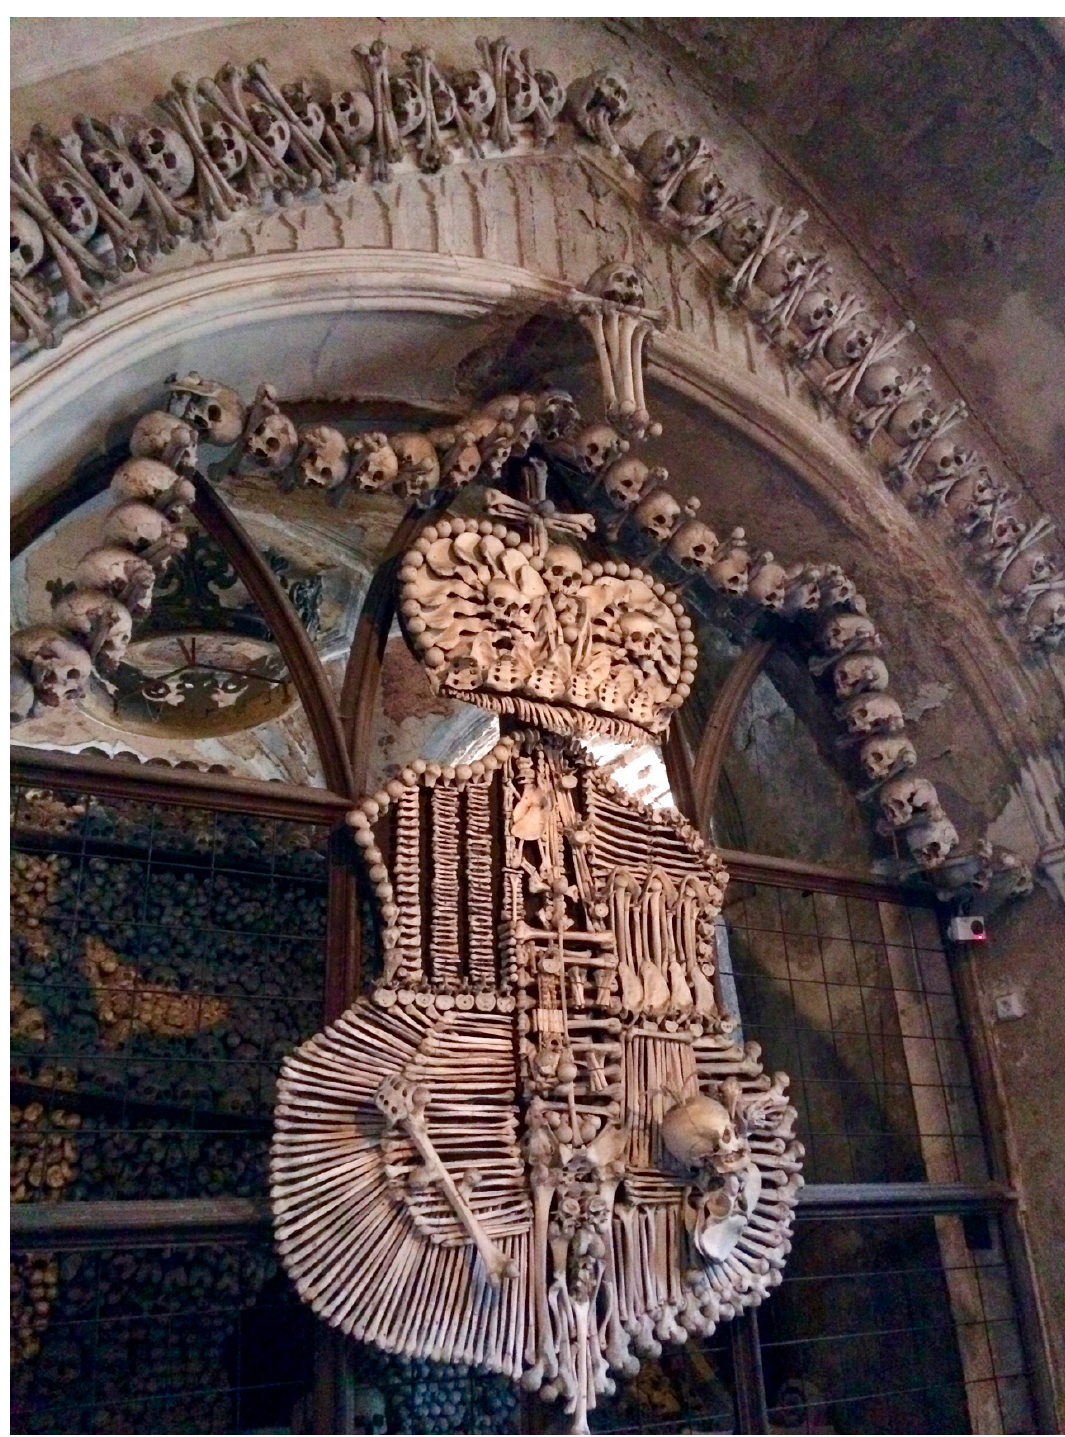
Figure 1. Sedlec Ossuary, crest of bones, interior, May 2016. Kelsey Perreault.